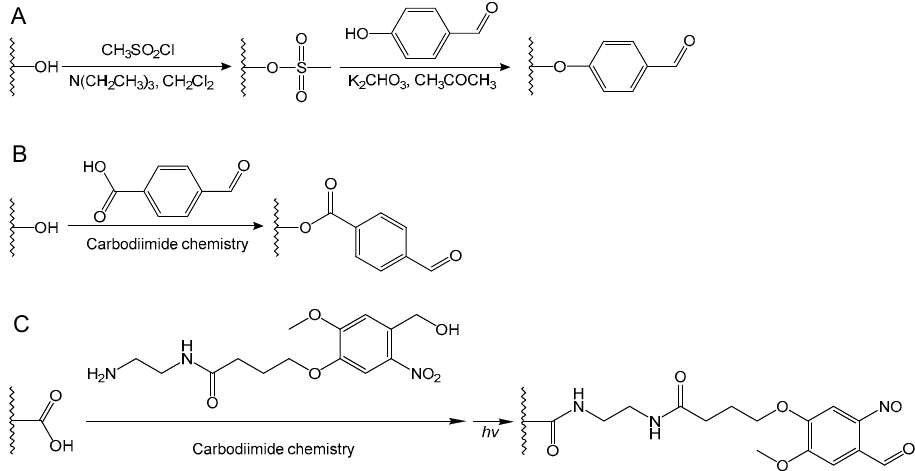
Figure 6. Synthesis of benzaldehyde-functionalized polymers through ( A ) a nucleophilic substitution reaction after the conversion of an alcohol to a mesylate; or carbodiimide chemistry coupling with the molecular containing benzaldehyde groups ( B ) or 2-nitrobenzyl alcohol groups ( C ). Photoreactive 2-nitrobenzyl alcohol can convert to 2-nitrosobenzaldehyde upon UV irradiation.